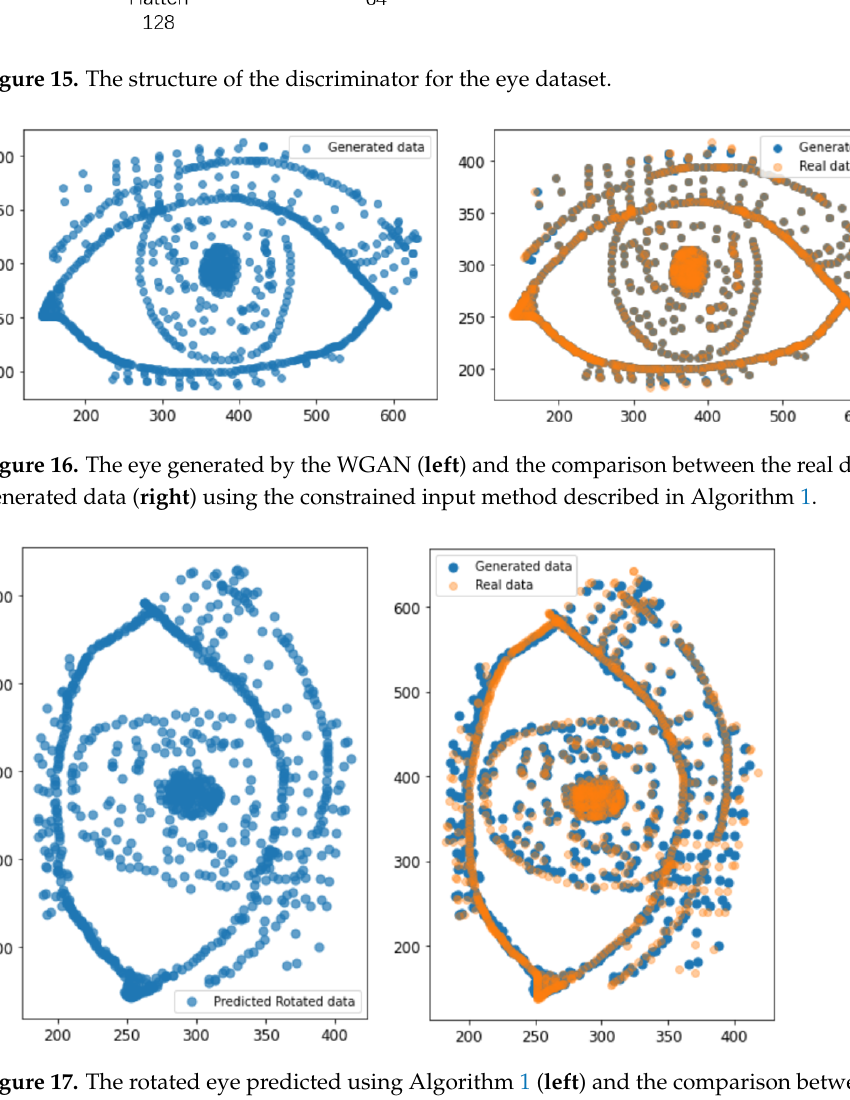
Figure 17. The rotated eye predicted using Algorithm 1 ( left ) and the comparison between the real rotated data and the predicted data ( right